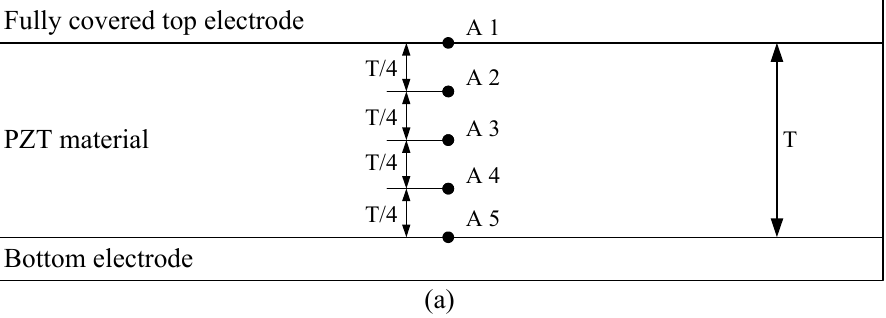
Figure 7. Points defined in the PZT materials: ( a ) fully covered electrode, ( b ) mesh top electrode, and ( c ) mesh top electrode with H-depth